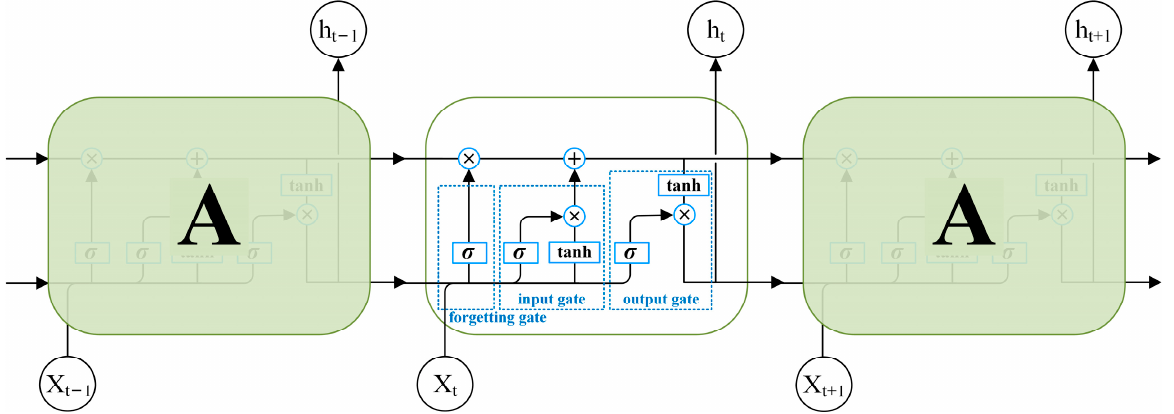
Figure 2. Structure diagram of long short-term memory.